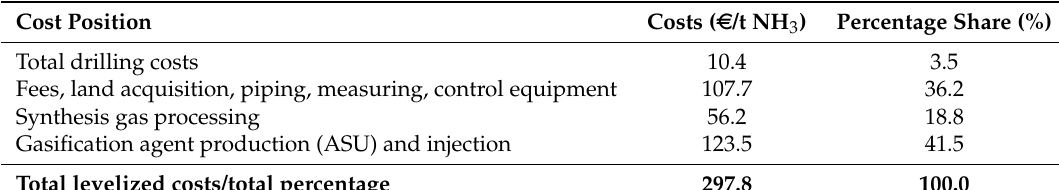
Table 16. Share of individual cost positions on levelized onshore ammonia production